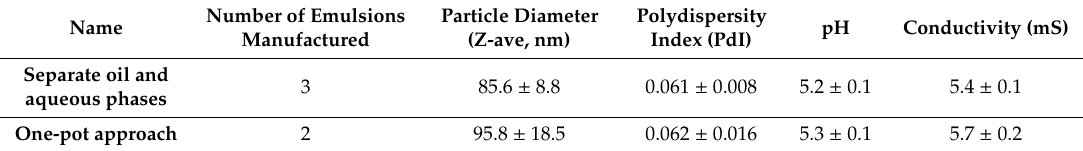
Table 4. E ff ect of the one-pot approach on emulsion droplet characteristics at small scale ( ≤ 200 mL).